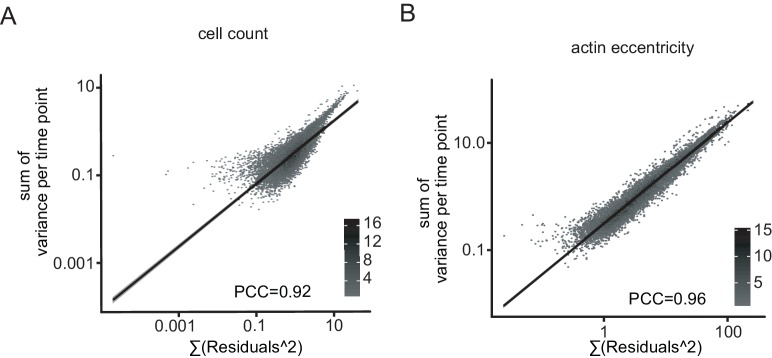
Robust linear models reliable quantify the differential interactions.(A) Robust linear model credibility. Residuals are compared to replicate variance for each time point, exemplarily shown for cell count (A, PCC = 0.92) and cell eccentricity (B, PCC = 0.96). Trendline indicates good agreement of residuals and variance.